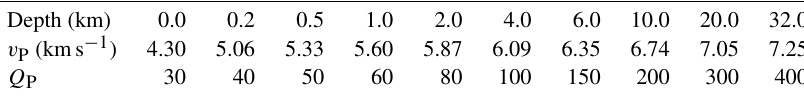
Table 2. The layered velocity